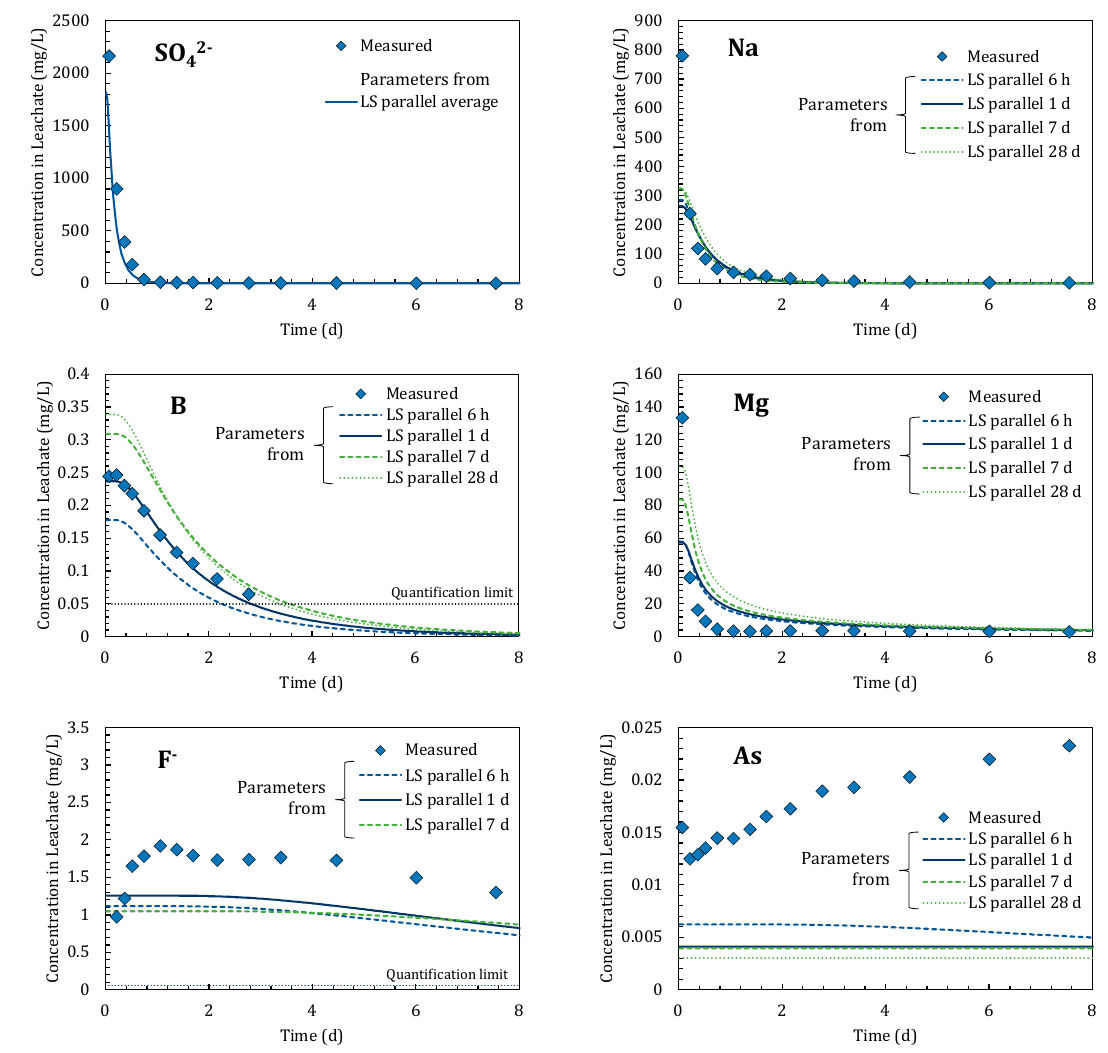
Figure 5. Column percolation test results and calculation results using parameters obtained in the LS-parallel tests. The maximum concentration is one of the most important parameters in evaluating the environmental impact of a given substance [31]. In the advection-dispersion model, the eluate concentration decreased monotonically. Thus, the first eluate represented the maximum concentration, which can be calculated using Equation (6). In Figure 5, SO 42 − , Na, B, and Mg showed their maximum concentrations in the first or the second eluate fractions. The calculated concentrations obtained by parameters from the LS-parallel test after one day were 67%, 38%, 96%, and 44% of measured SO 42 − , Na, B, and Mg values in the column test, respectively; this timing would provide the best comparison to the measured results because the initial run of the eluate took 16.3 h. For SO 42 − , Na, and B